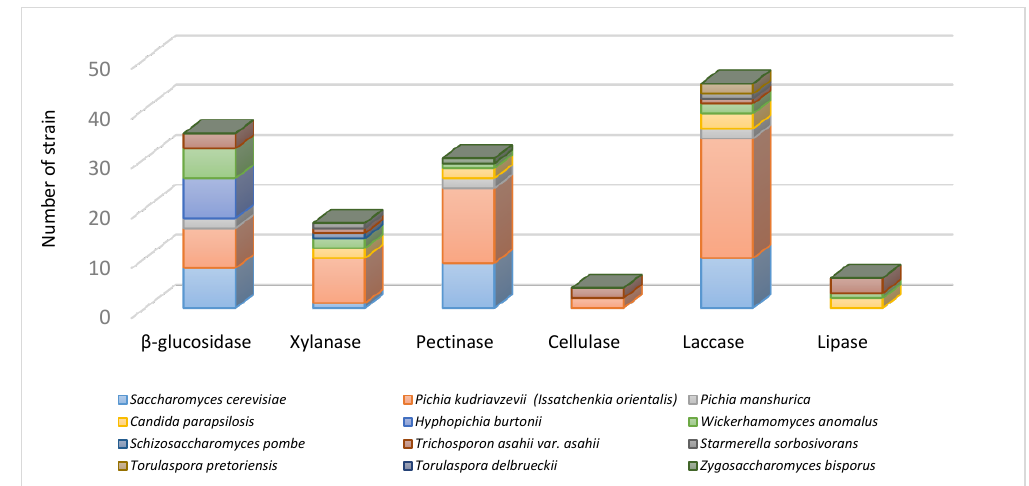
Figure 1. Extracellular enzyme activities showed by the different yeast species, isolated from cocoa fermented and dried beans, incubated at 25 °C for three days